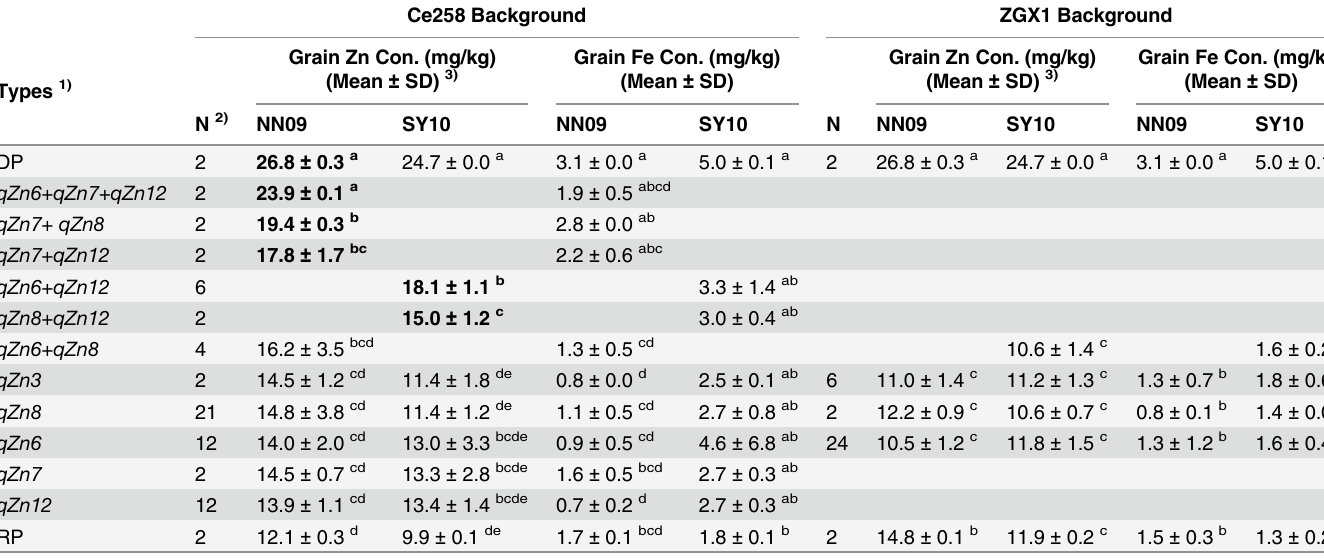
Table 5. Pyramiding effects of IR75862 alleles on grain Zn concentrations in the Ce258 background in Nanning (NN09) and Sanya (SY10). Ce258